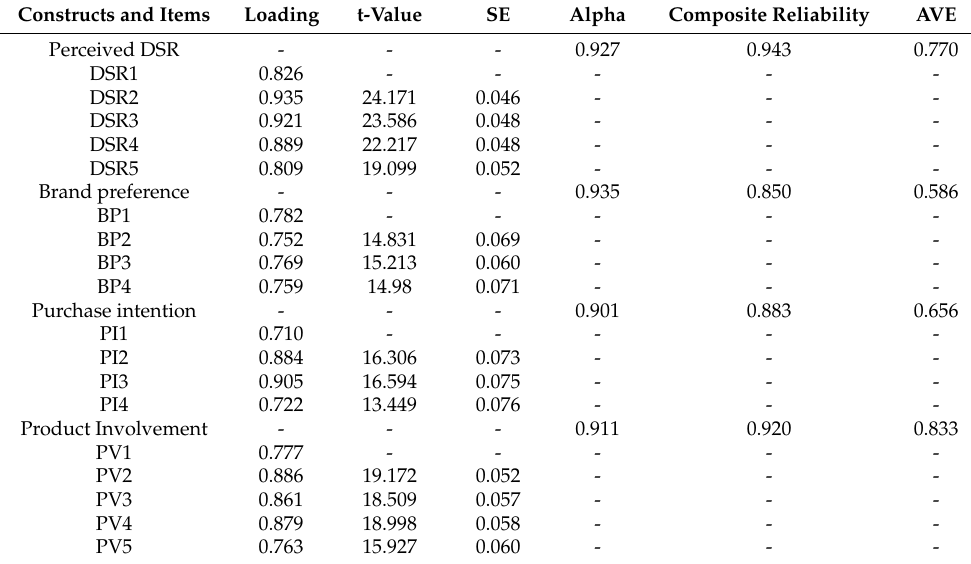
Table 3. Measurement model’s summary items and constructs.